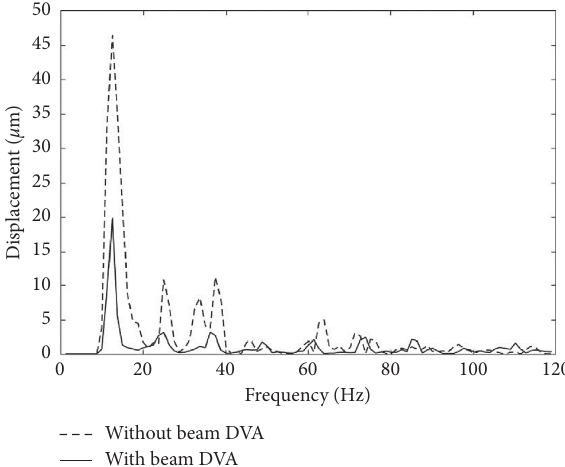
Figure 10: Experimental results of the 1-inch pipeline structure with the inverter operating at around 12.5